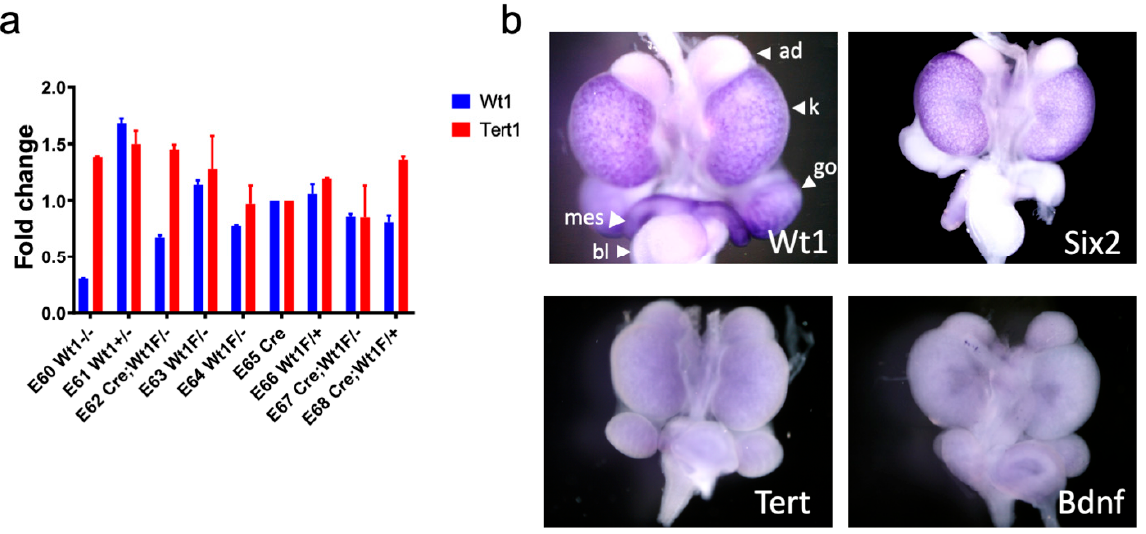
Figure 5. Tert and Wt1 are not related in kidney development. ( a ) RNA was isolated from murine embryonic kidneys and Wt1 and Tert expression levels were compared by qRT-PCR. No relationship was seen between Wt1 and Tert expression levels; most notably E60, E62, and E67 with biallelic loss of Wt1 did not exhibit reduction in Tert levels. ( b ) Whole mount in situ hybridization data from the GUDMAP database [34,35] demonstrates detection of Wt1 (4 × magnification) in the peripheral nephrogenic zone of e15 mouse embryonic kidneys (k) and is also seen in the gonads (go) and mesonephric ducts (mes). As a positive control, Six2 (3.5 × magnification) is also seen in the peripheral nephrogenic zone and in a distribution similar to Wt1 in the e15 mouse embryonic kidneys. Tert (3.5× magnification) is not significantly detected in e15 kidneys. Bdnf (brain-derived neurotropic factor; 3.5× magnification) is shown as a negative control. Bladder-bl, Adrenal gland-ad.